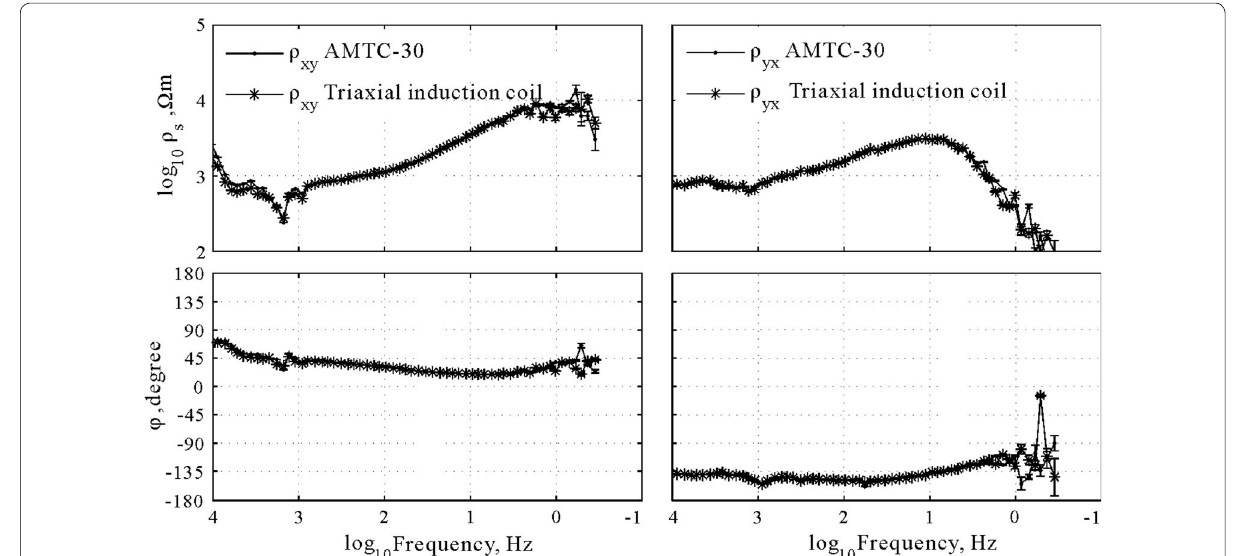
Fig. 13 MT response sounding curves of the two types of induction coils